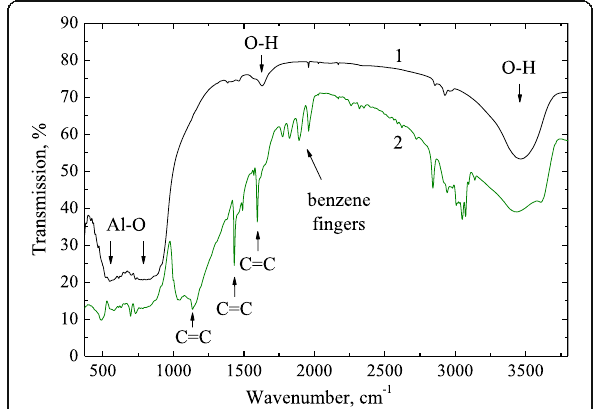
Fig. 1 FTIR transmission spectra of pristine fumed alumina before (spectrum 1) and after chemical treatment (spectrum 2). Spectra are offset along the ordinate axis for clarity